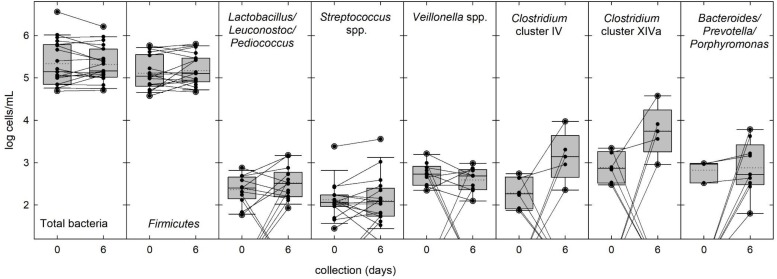
Bacterial populations in fresh and stored breast milk samples. The abundance of total bacteria and of selected bacterial groups commonly present in breast milk was determined by qPCR. Boxes indicate the 25th and 75th percentiles. Whiskers indicate 10th and 90th percentiles, 5th and 95th percentiles are shown as dots. The dotted and solid lines indicate mean and median, respectively. Cell counts of individual samples and changes in abundance during storage are indicated by black dots and connecting lines.